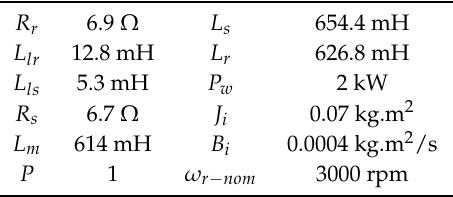
Table 1. Characteristics of the six-phase